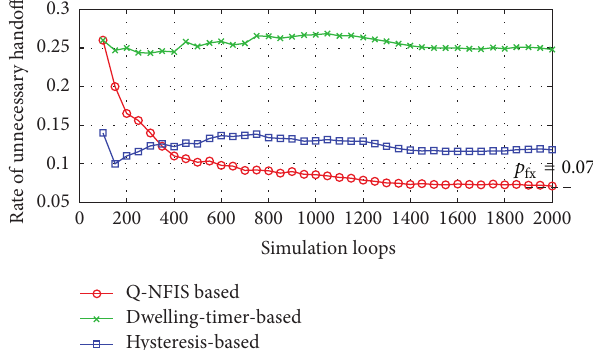
Figure 6: Comparison of unnecessary handoff rate for 3 algorithms in 2000 simulation loops.